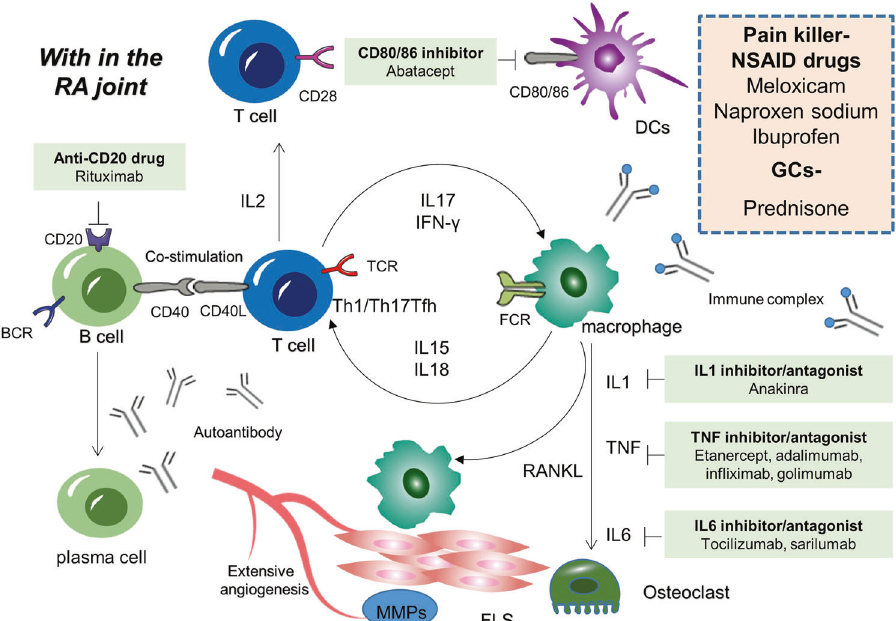
Fig. 4 Cytokine signaling and anti-rheumatic drugs in RA. In the presence of certain environmental or genetic factors, a stepwise progression from activation of innate immunity can be achieved by stimulating DCs, then recruiting and activating T cells, which in turn stimulate B cells, macrophages, synoviocytes, chondrocytes, and osteoclasts to secrete pro-in fl ammatory and bone-destroying cytokines (i.e., IL-1 β , IL-6, TNF- α , and matrix metalloproteinases (MMPs), resulting in bone and cartilage damage accompanied by synovial membranes thickening and angiogenesis, in the synovium and adjacent bone marrow, and the integration of adaptive and innate immune pathways to promote tissue remodeling and damage drives the chronic phase of RA. Clinically, drugs that target in fl ammatory cytokine signaling are commonly